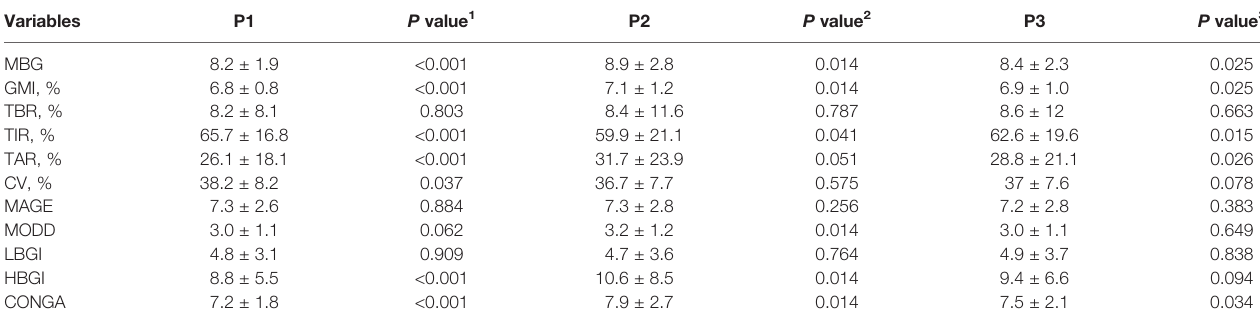
TABLE 2 | Changes in CGM metrics of study participants (n = 71) during the Chinese New Year public holiday. Variables P1 P value